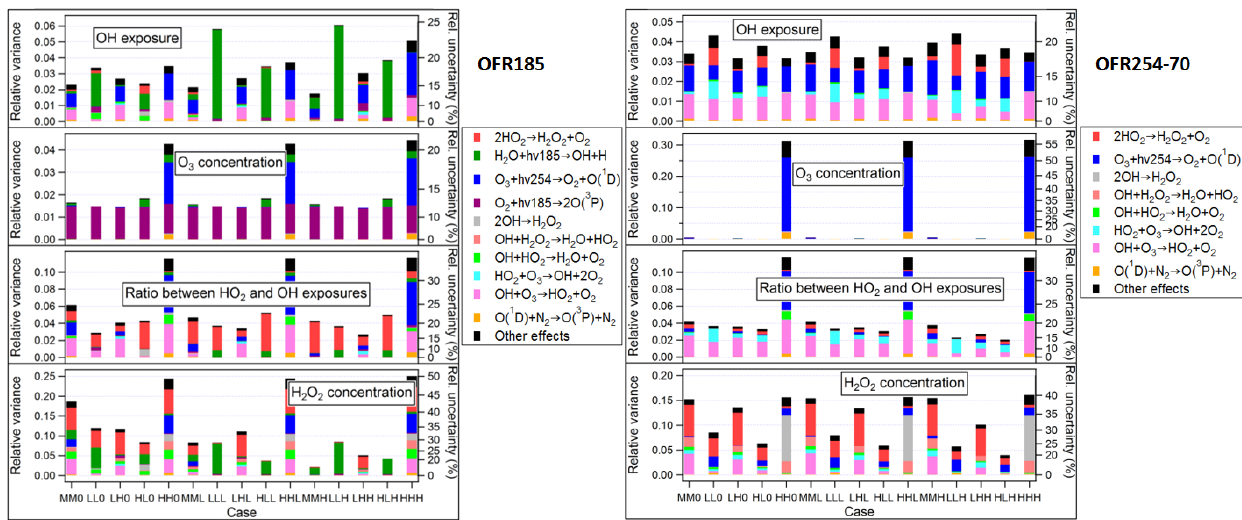
Figure 6. Relative variances (left axes)/uncertainties (right axes) of the outputs (i.e., OH exposure, O 3 concentration, ratios between HO 2 and OH exposure, and H 2 O 2 concentration) of Monte Carlo uncertainty propagation, and relative contributions of key reactions to these relative variances in typical cases in OFR185 and OFR254-70. Relative variances are shown in linear scales (left axis), while corresponding relative uncertainties, equal to relative variances’ square roots, are indicated by the non-linear right axis. Only the reactions with a contribution of no less than 0.04 to at least 1 relative variance are